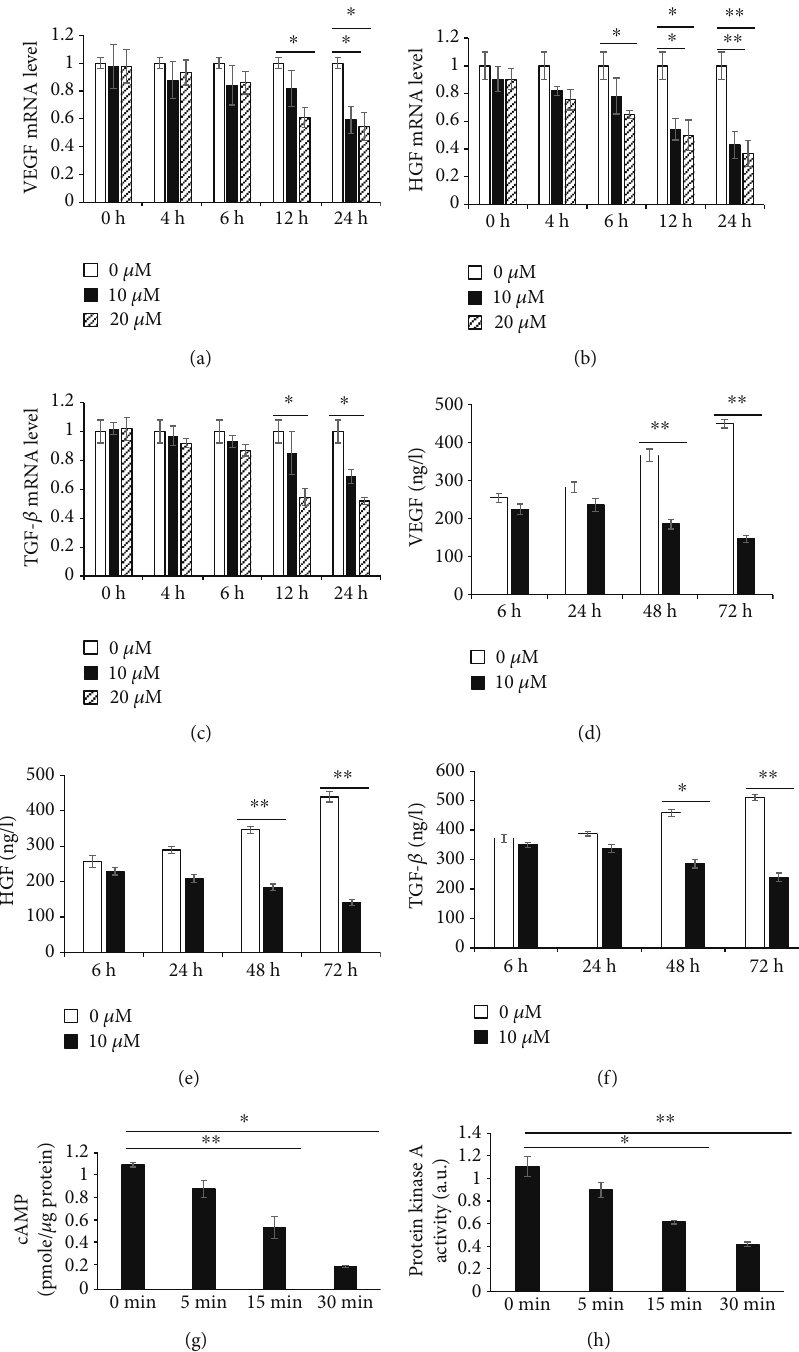
Figure 4: Clonidine reduces the expression and secretion of growth factors in C57BL/6 ASCs. The mRNA expression levels of VEGF (a), HGF (b), and TGF- β (c) at 0h, 4h, 6h, 12h, and 24h of C57BL/6 ASCs treated with 10 μ M and 20 μ M of clonidine, respectively. Secretion of VEGF (d), HGF (e), and TGF- β (f) at 6 h, 24h, 48 h, and 72h of C57BL/6 ASCs treated with 10 μ M clonidine. Clonidine reduces contents of cAMP and PKA in C57BL/6 ASCs. The contents of cAMP (g) and PKA (h) at 0min, 5 min, 15 min, and 30min with 20 μ M clonidine treatment. Three biological replicates and three technical replicates were used in each case. ∗ P < 0 : 05 ; ∗∗ P < 0 : 01